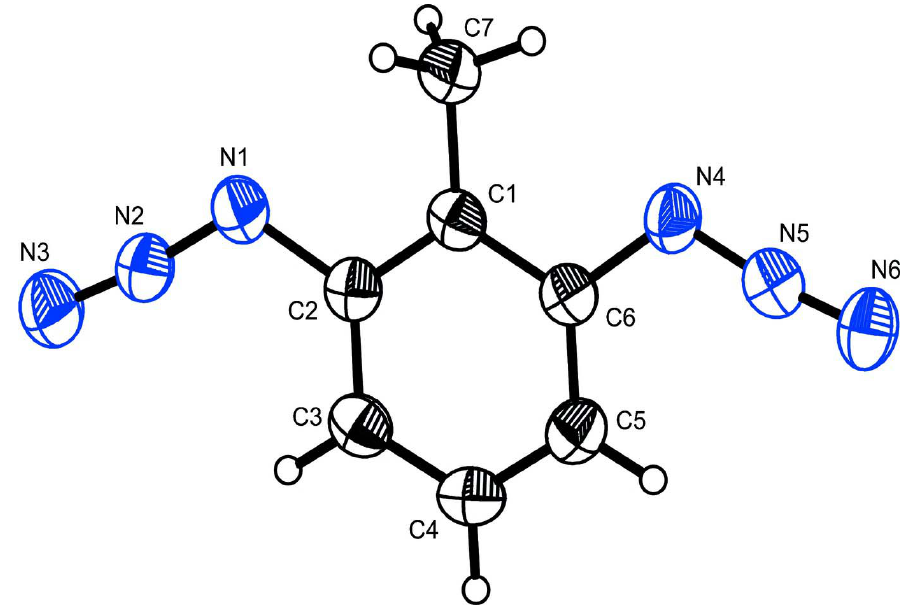
Molecular structure of C component of the methyl hydrogen atoms has been